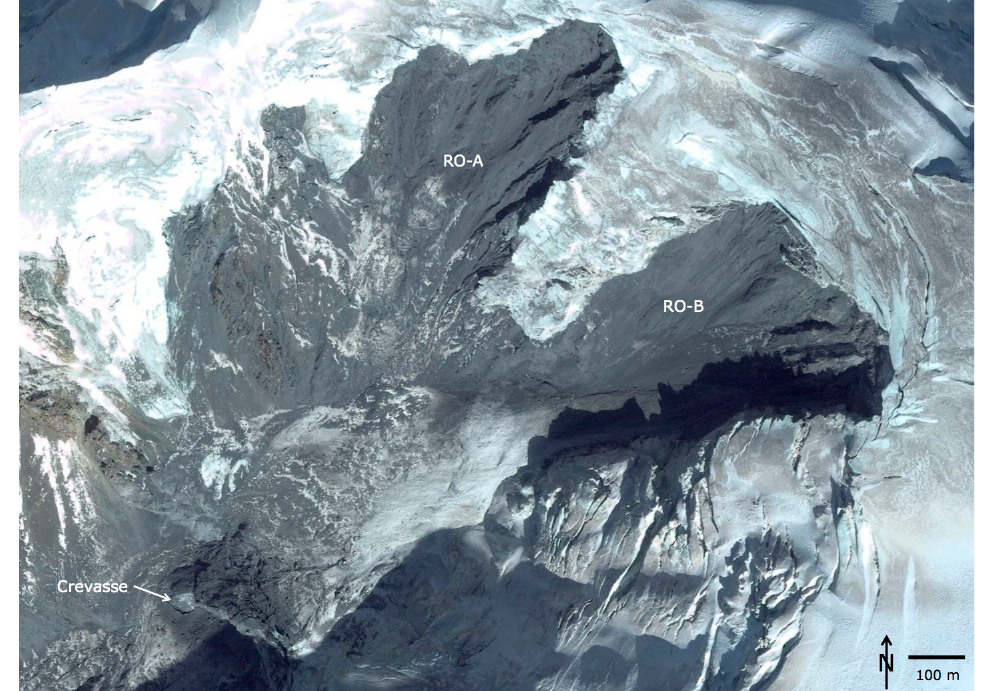
Figure 12. Close-up of the instable slope with the two large, heart-shaped rock outcrops (RO-A and RO-B) that have merged in the meantime. Some remaining debris-covered ice is visible (partly snow covered) in the outcrops that seem to be covered with dark and fine-grained sediment. The former eastern accumulation area is now limited to a small remaining tongue (cf. Figures 4 and A1). A larger piece of ice in the valley floor is still connected to the southern tributary but a large crevasse is separating it from the rest of the glacier. Image source: Screenshot from bing.com.